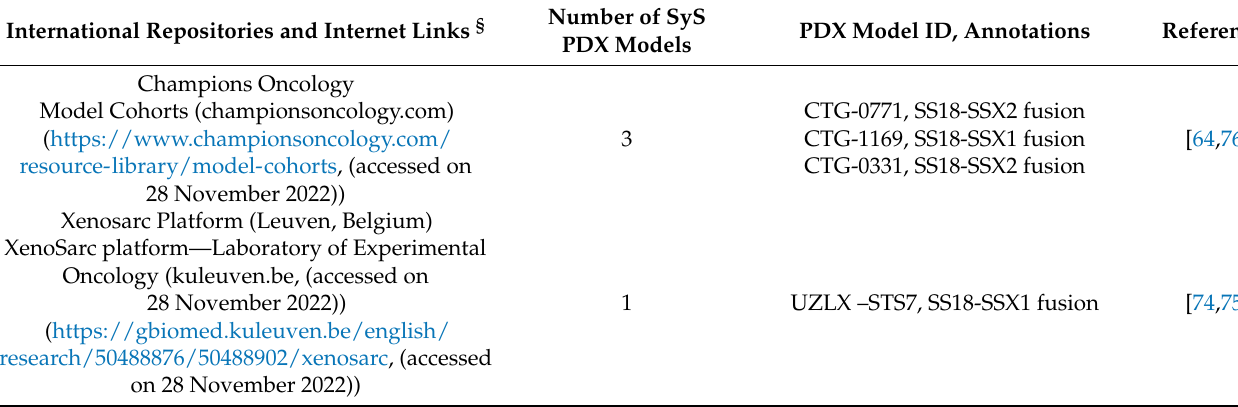
Table 5. SyS PDX models in international